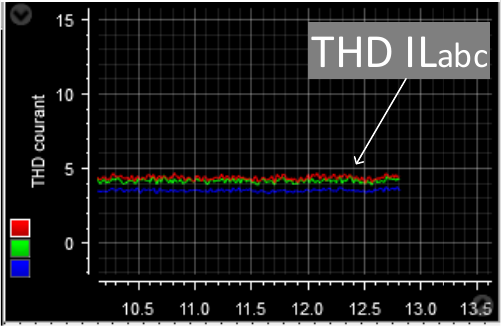
Figure 21. THD (%) of the grid current in a steady state (0% corresponds to no harmonics).